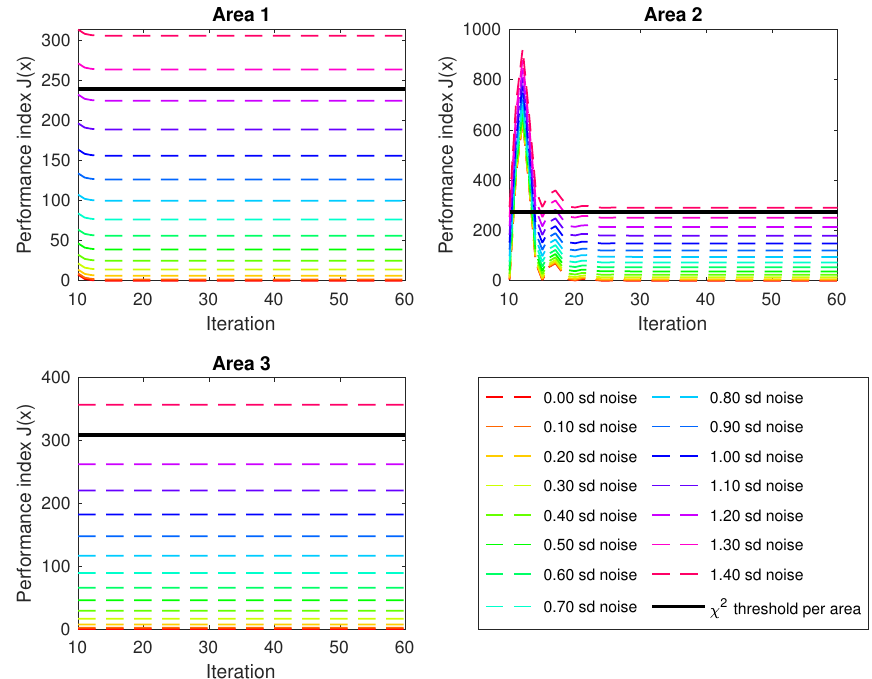
Figure 11. Performance index for different noise level on the IEEE-118 bus system 3